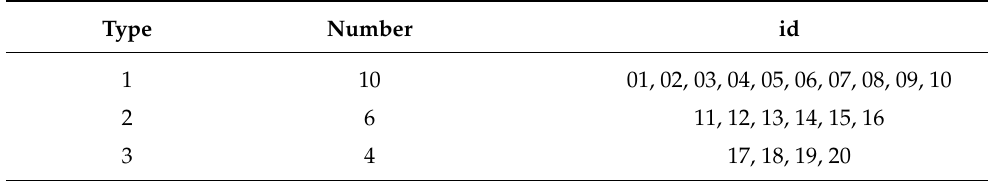
Table 1. The sag types and number of data